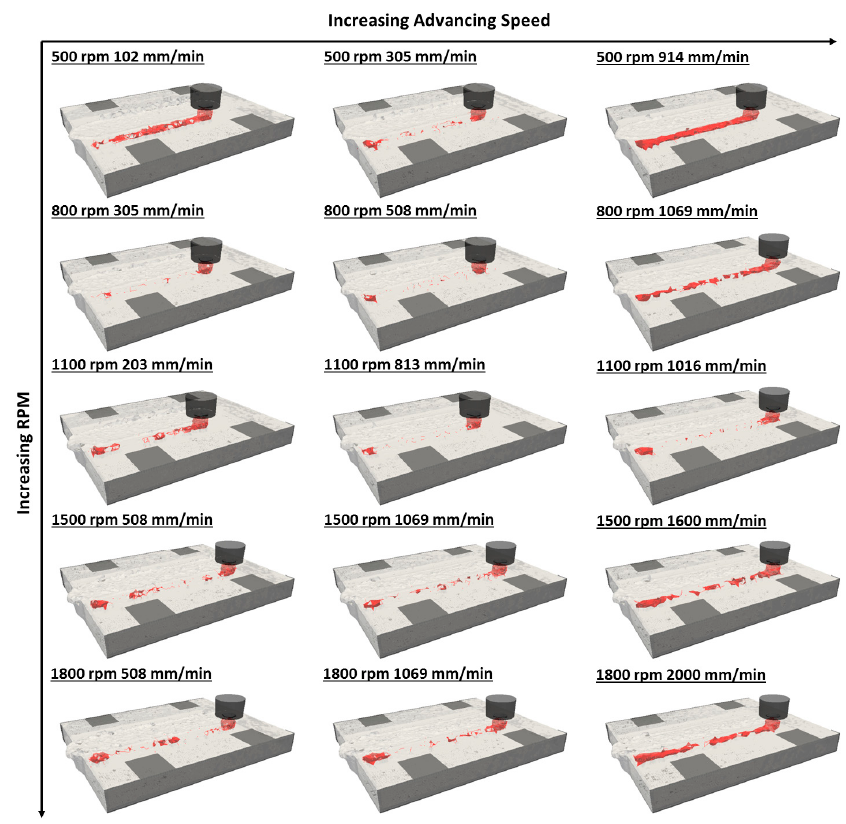
Figure 11. Predicted defects for the 15 cases.